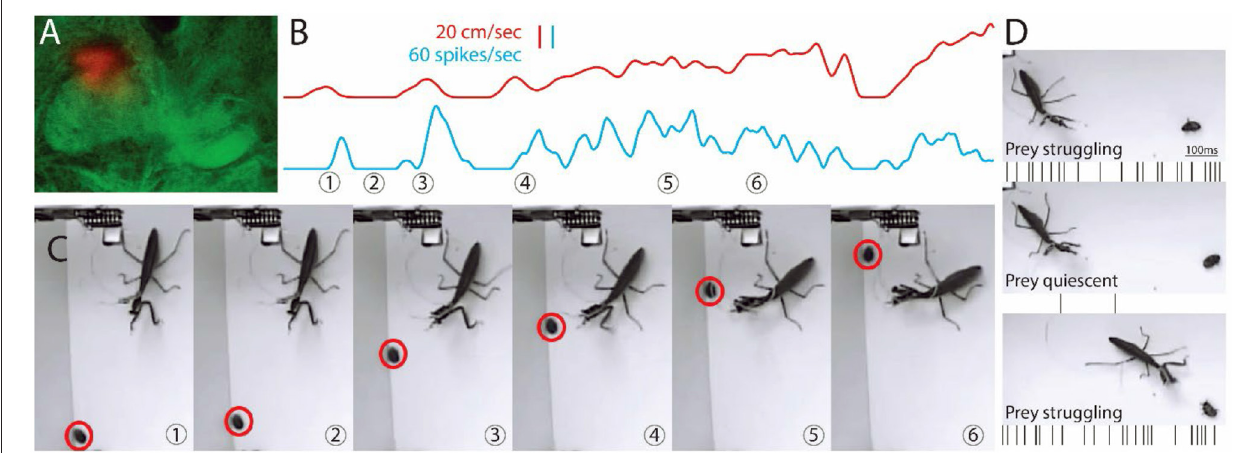
FIGURE 1 | Images from video and recording of a single unit during hunting behavior. (A) Location of a tetrode is shown in the dorsal region of the FB on the mantis’s right side. (B) Shows the activity of the cell (blue) along with the movement of the prey (red). (C) Sample frames from Supplementary Video S1 are shown with time of frame numbers indicated in (B) . (B,C) Prey starts to move in first frame. Central complex (CX) unit activity increases and then stops when the prey stops (2nd frame). In frame 3, the prey runs as the mantis tracks it, and CX unit activity increases and is maintained through frame 6. Before the mantis tracks the prey, the single CX unit is correlated with mantis movement (r > 0.7, sliding Pearson’s coefficient). After the mantis orients toward the prey, the same unit is correlated (r > 0.7) with prey movement. (D) Another prey is on its back and struggles (top) and then stops (middle) and struggles again just before the strike. Activity, shown here as spikes below each frame, is parallel to